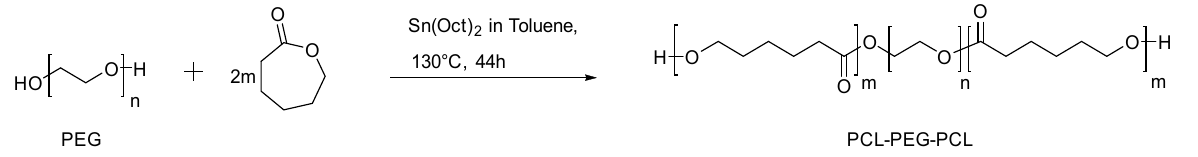
Scheme 1. Synthesis of triblock PCL-PEG-PCL copolymer.